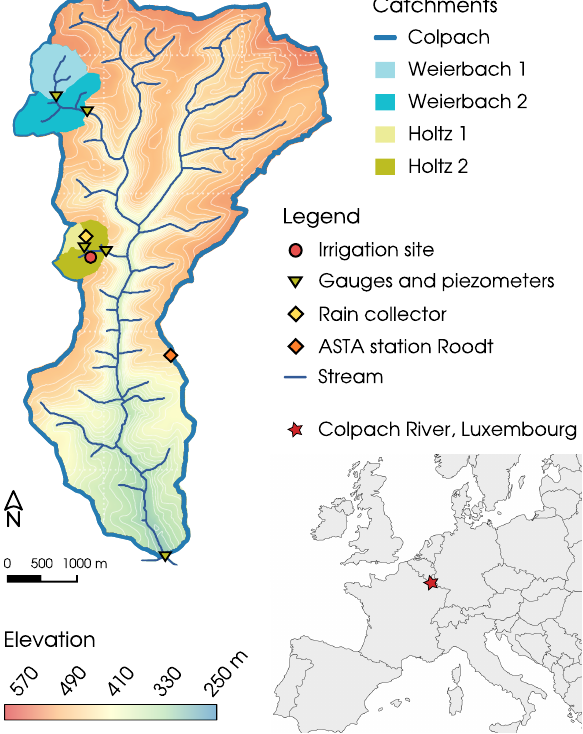
Figure 2. Map of the investigated Colpach River catchment and the four gauged sub-catchments. The site of the hillslope-scale irriga- tion experiment is located in the Holtz 2 catchment and is indicated in red.